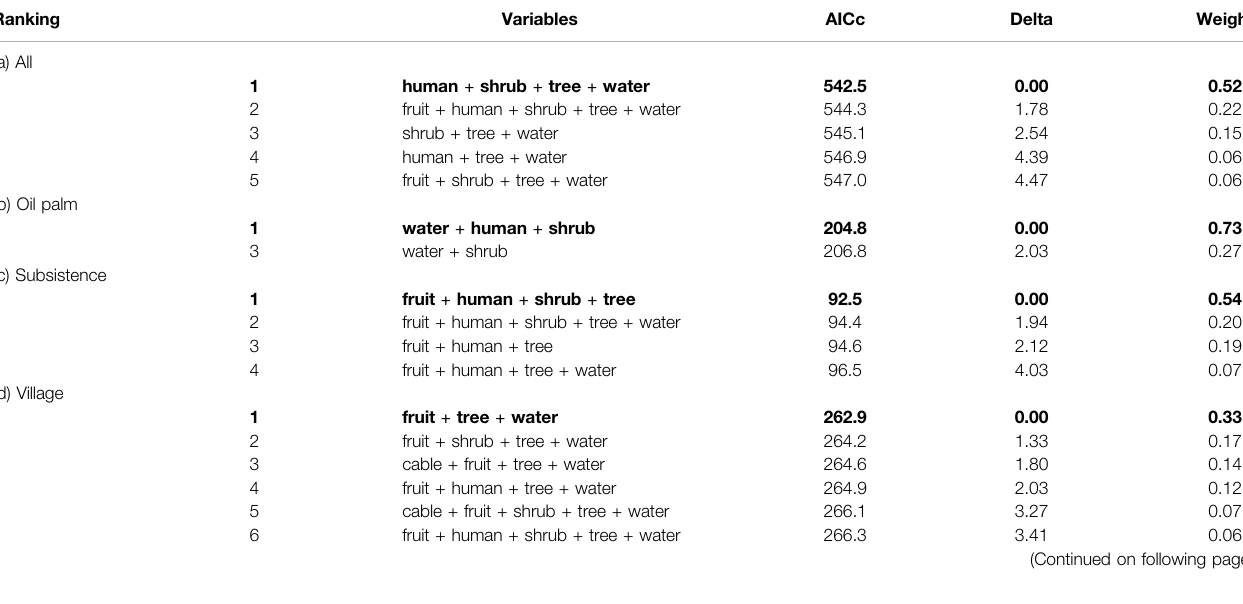
TABLE 2 | Rankingofthebeststatisticalmodelswhichwereretainedineachcon fi denceset,wheretheAkaike ’ sdifference(Delta) withthetop-rankedmodelwaslessthan5.0, following the Information Theoretic approach, for (a) all habitats and taxa combined, (b) oil palm, (c) subsistence agriculture, (d) village, and (e) rainforest habitats. The